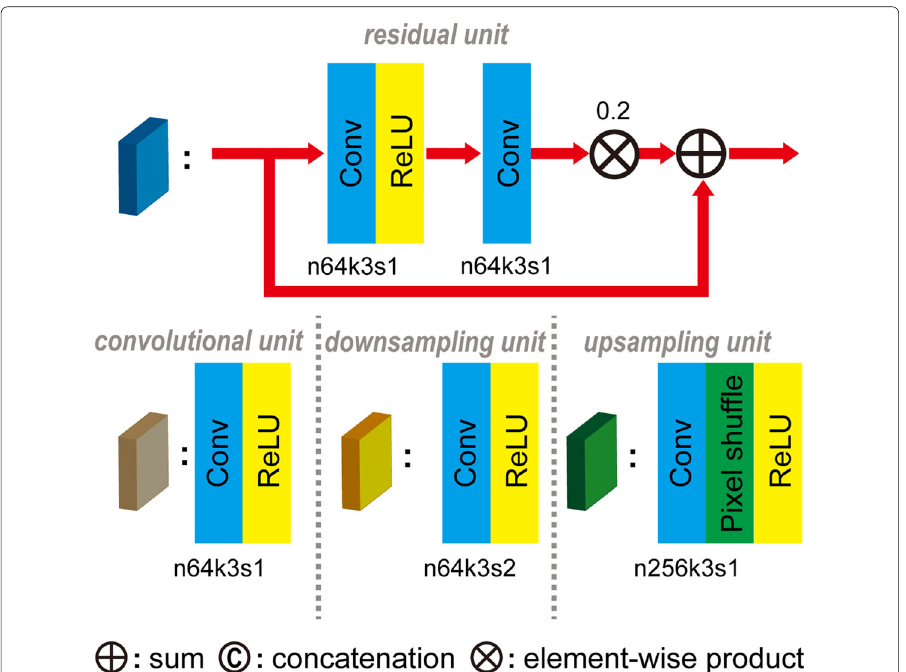
Fig. 3 Network units. The basic units of the network in Fig. 2. The output channel size ( n ), the kernel size ( k ), and the stride ( s ) are indicated for each convolutional layer. The input channel size can be deduced by comparing the output channel sizes of two neighboring